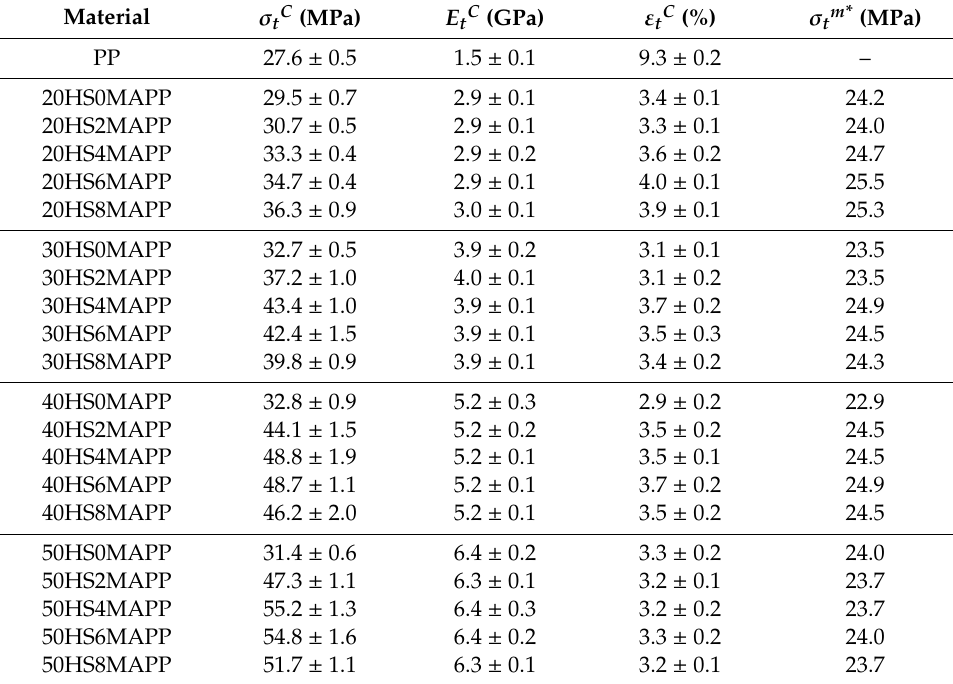
Table 1. Result of the tensile test of hemp strand reinforced polypropylene composites at di ff erent coupling agent